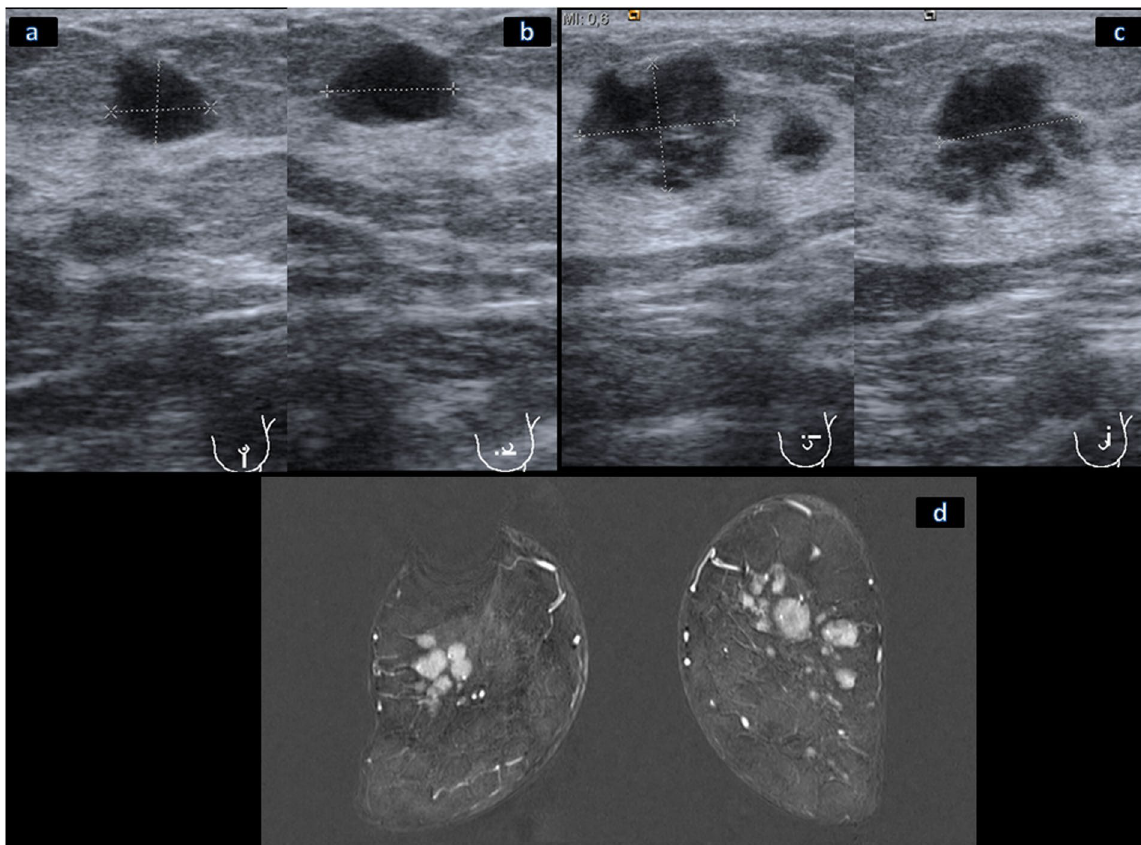
Figure 4. Ultrasound imaging findings in a 64-year old woman with breast T-cell lymphoma. The horizontal ( a ) and vertical ( b ) imaging planes demonstrated an oval, hypoechogenic mass with indistinct margins and without posterior acoustic features, located in the 6 o’clock position of the left breast. Another lesion in the upper outer quadrant of the left breast demonstrated in the vertical and horizontal imaging planes an irregular, complex cystic and solid mass with indistinct margins and with combined posterior acoustic pattern ( c ). The MRI imaging in coronal view ( d ) documented in the subtraction images multiple round and oval intramammary masses of both breasts with irregular margins and a homogeneous intensive